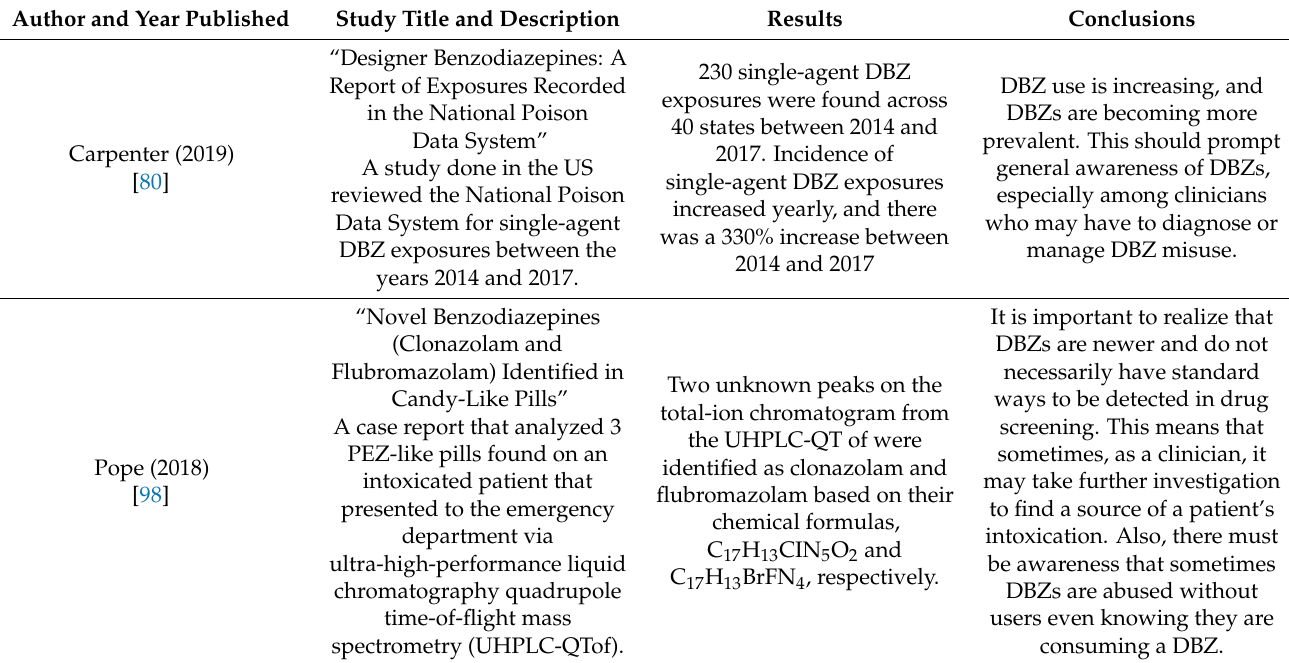
Table 1. Summary of clinical